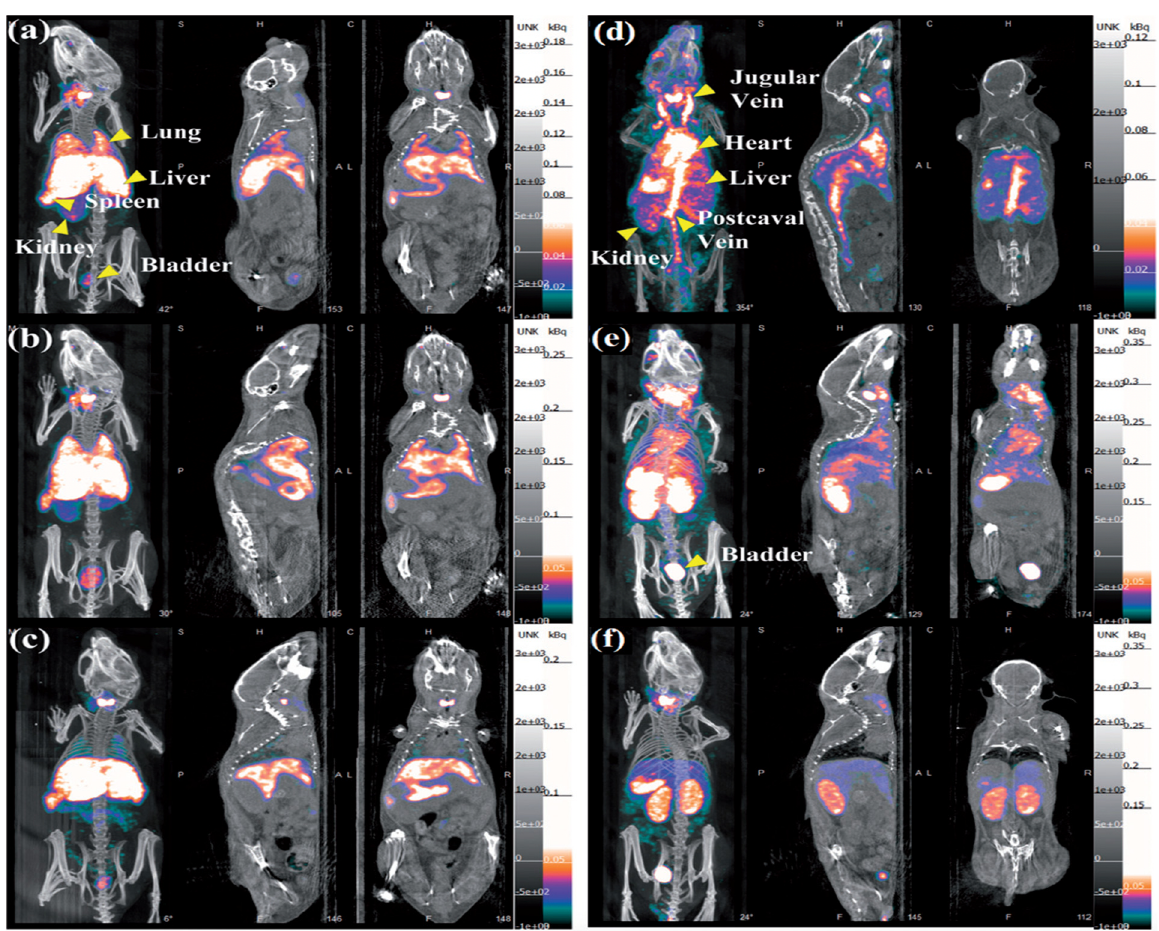
Figure 12. SPECT/CT images of mice injected with 99m Tc-Au-Ac-PENPs at ( a ) 0.5 h, ( b ) 1 h and ( c ) 2 h; SPECT/CT images of mice injected with 99m Tc-Au-Gly-PENPs at ( d ) 0.5 h, ( e ) 1 h and ( f ) 2 h [154].